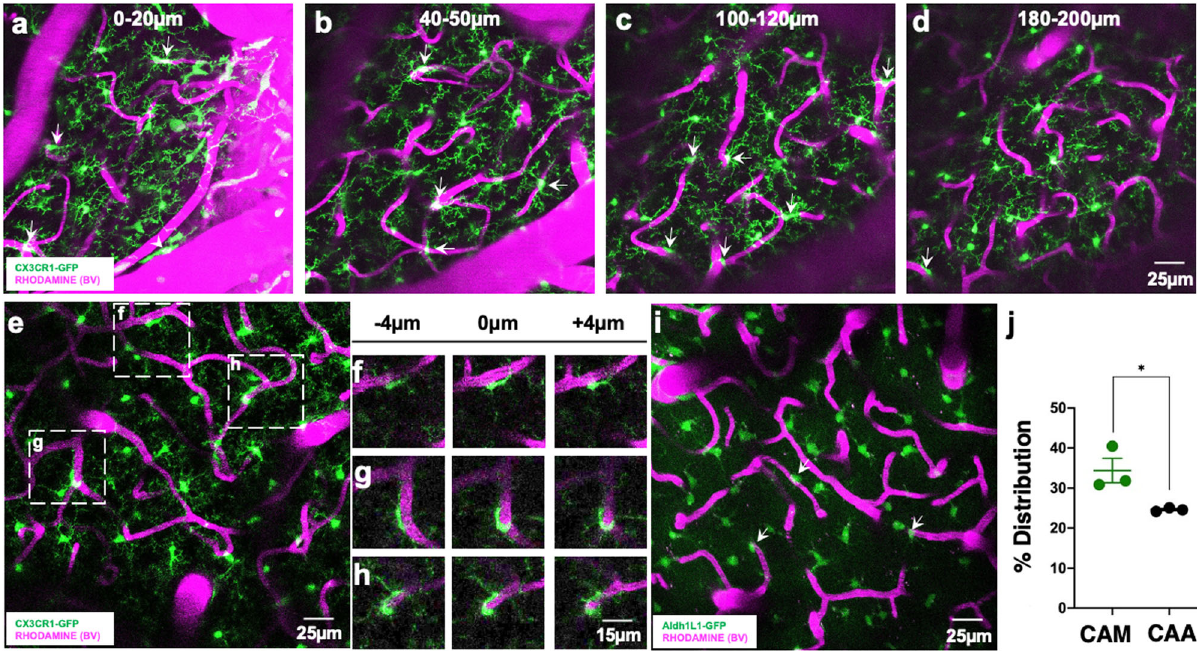
Fig. 1 Rami fi ed CX3CR1 + myeloid cells associate with brain capillaries. a – d Representative 20- µ m-thick two-photon projection images from a CX3CR1 GFP/ + adult brain showing myeloid cells (green) and the vasculature (rhodamine in magenta) at varying tissue depths between the brain surface and 200 µ m of the cortex. Arrows identify capillary-associated rami fi ed myeloid cells. e Representative 20- µ m-thick in vivo two-photon image from a CX3CR1 GFP/ + adult brain showing rami fi ed myeloid cells (green) and the vasculature (rhodamine in magenta) in the cortex. f – h Representative images from boxed regions in ( e ) showing somal interactions between the rami fi ed myeloid cells and capillaries in an 8 µ m tissue volume. i , j Representative 20- µ m-thick two-photon projection image ( i ) and quanti fi cation ( j ) from an ALDH1L1 GFP/ + P30 brain showing astrocytes (green) and the vasculature (rhodamine in magenta) in the cortex. Capillary-associated astrocytes (CAAs, arrows in i ) density is compared to capillary-associated myeloid (CAM) density. n = 3 mice each. Representative images in ( a – h ) were observed in fi ve mice and in ( i ) was observed in three mice. Data are presented as mean values ± SEM. * p < 0.05. Two-sided unpaired Student ’ s t